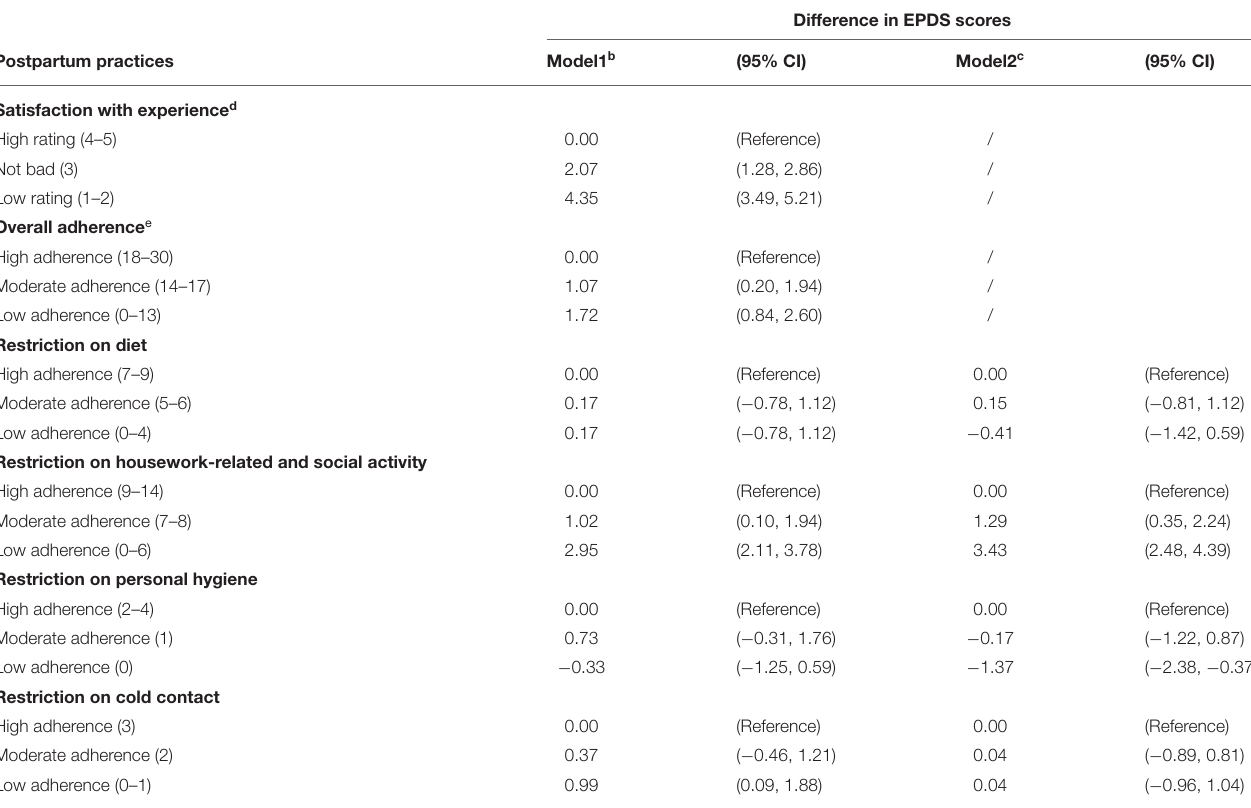
TABLE 3 | Mean difference in EPDS scores according to postpartum practice experience and adherence a